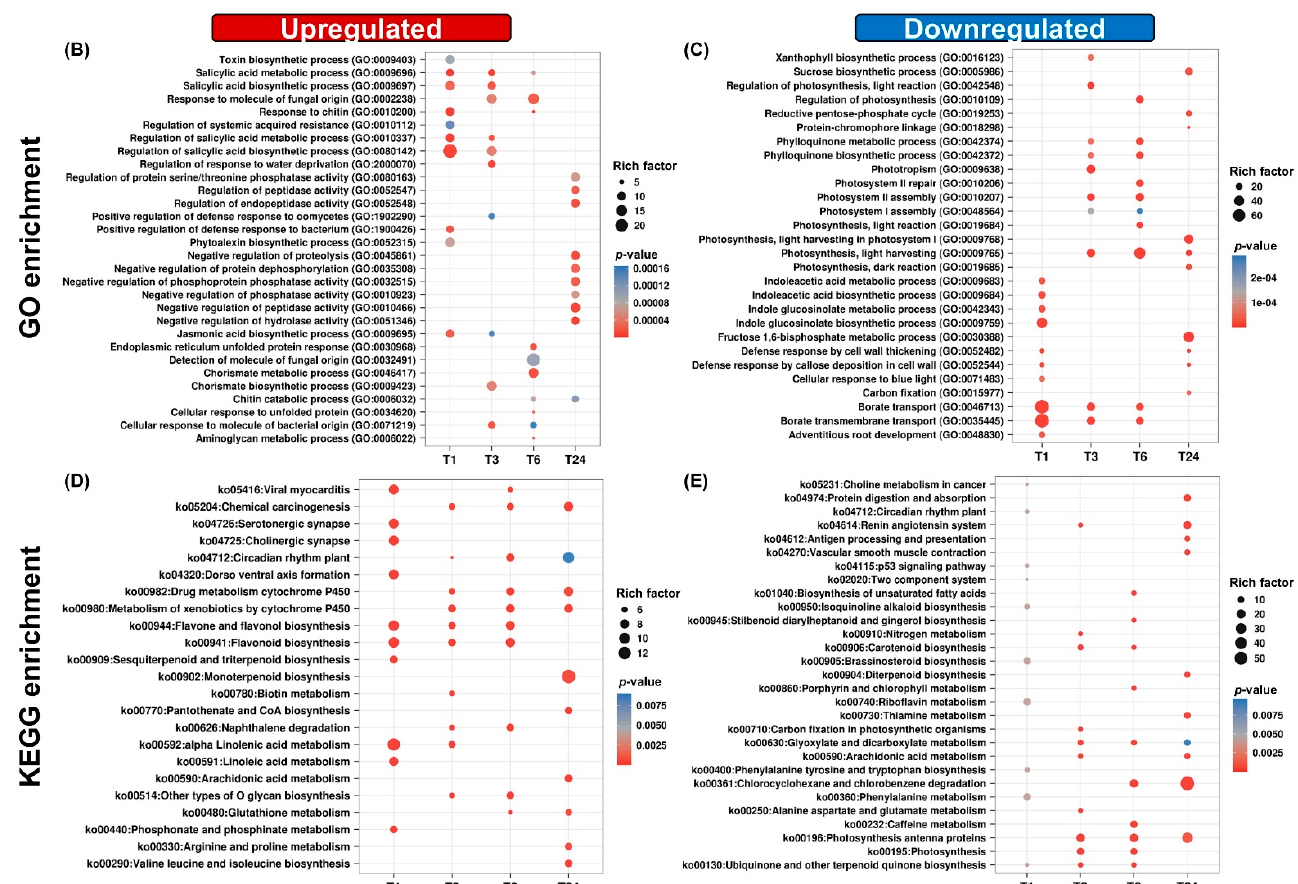
Figure 2. Gene ontology (GO) and Kyoto Encyclopedia of Genes and Genomes (KEGG) pathway enrichment analysis of the differentially expressed genes (DEGs) following wounding of S . tora leaves. ( A ) Histogram of the GO classification of the DEGs. The results are summarized in three main categories: biological process, cellular component, and molecular function. ( B , C ) Dot plot of the GO enrichment of the DEGs. The color of each circle represents the p -value of the GO terms associated with the DEGs at that timepoint compared with T0. The size of the circle indicates the gene-rich factor, which was defined as the ratio of the DEGs assigned to the GO term/all genes assigned to that GO term. ( D , E ) Dot plot of KEGG pathway enrichment for the DEGs. The color of the circle represents the p -values of the KEGG pathway terms associated with the DEGs at that timepoint compared with T0. The size of the circle represents the gene-rich factor, which was defined as the ratio of the DEGs assigned to the KEGG pathway term/all genes assigned to that KEGG pathway term. The dot plots were generated using the ggplot function in the R package ggplot2.